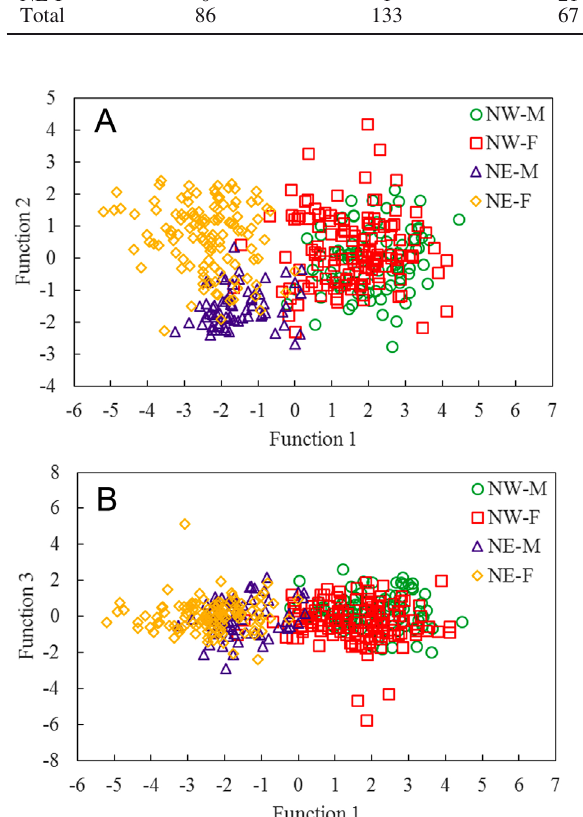
Fig. 5. – Canonical discriminant plots of combined with standard- ized statolith and beak morphometric variables of samples in each sex from the two stocks in the North Pacific Ocean.